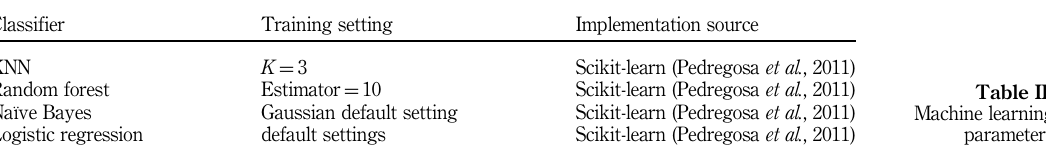
Table II. Machine learning